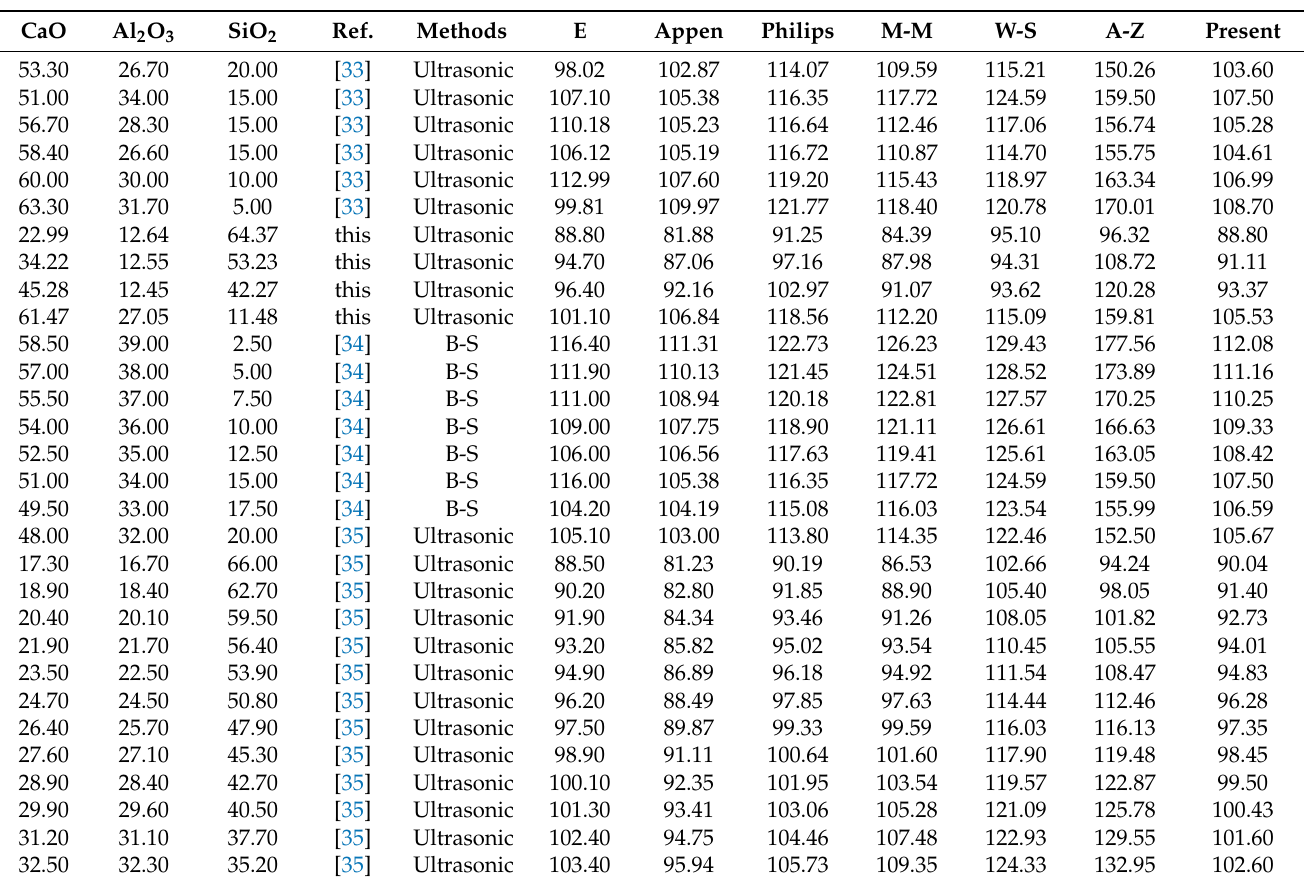
Table 3. The comparison between experimental (E) and calculated Young’s modulus values by various models (M-M: Makishima and Mackenzie, W-S: Winkelmann and Scott, A-Z: Ashizuka and Zhang, Present: the present modified Appen’s equation). Experimental data based on measurements using Resonant ultrasound spectroscopy (Ultrasonic) or by Brillouin scattering method